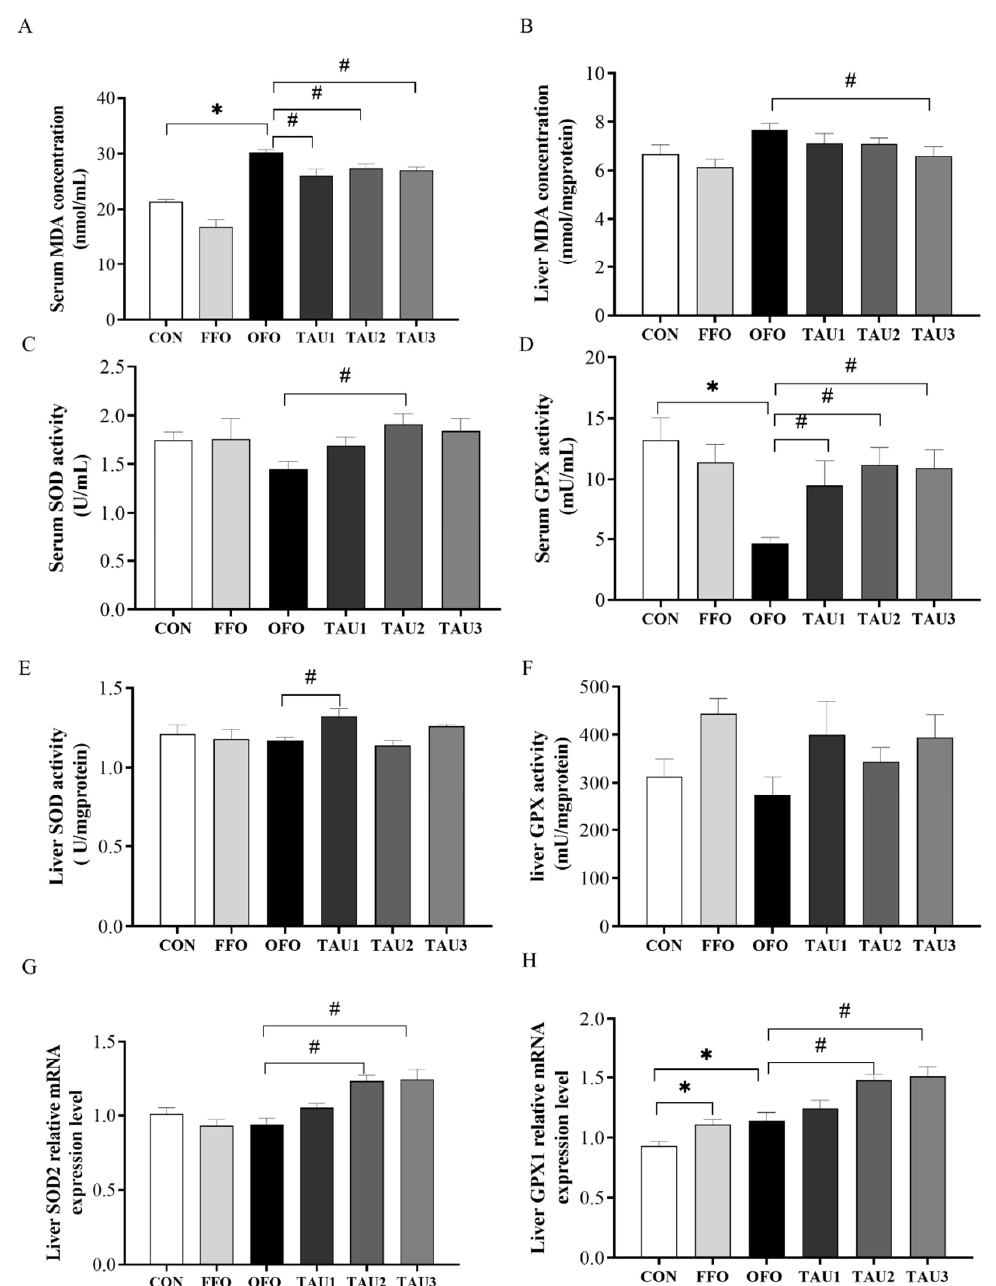
Figure 3. The serum MDA ( A ), liver MDA ( B ), serum SOD ( C ), serum GPX ( D ), liver SOD ( E ), liver GPX ( F ), relative mRNA expression levels of SOD2 ( G ) and GPX1 ( H ) in liver of all groups of mice. ICR mice were fed a normal (CON), normal plus fish oil diet (FFO), normal plus oxidized fish oil diet (OFO), or OFO plus 0.6% (TAU1), 0.9% (TAU2) or 1.2% (TAU3) taurine diet for 10 weeks. Each value represents the mean ± SEM ( n = 10). * p < 0.05 vs. the CON group and # p < 0.05 vs. the OFO group. MDA, malondialdehyde; SOD, superoxide dismutase; GPX, glutathione